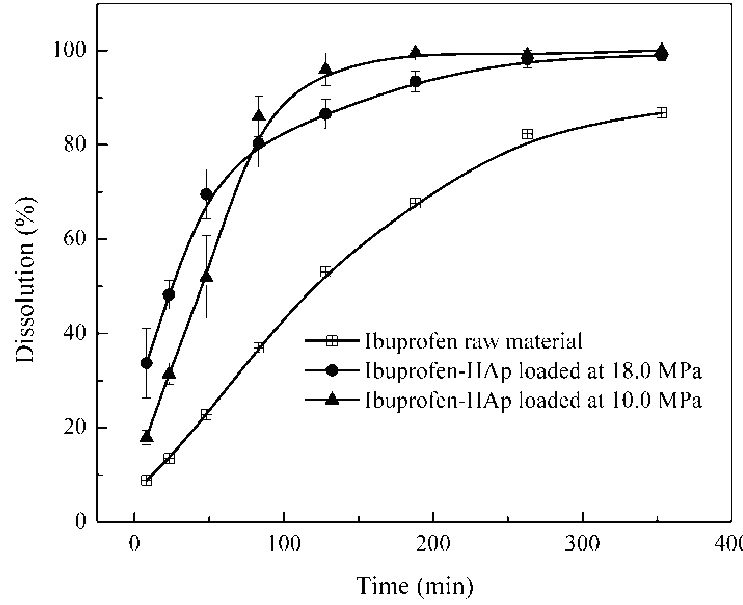
Figure 5. Dissolution profiles for ibuprofen raw material and ibuprofen-HAp samples in a simulated gastric